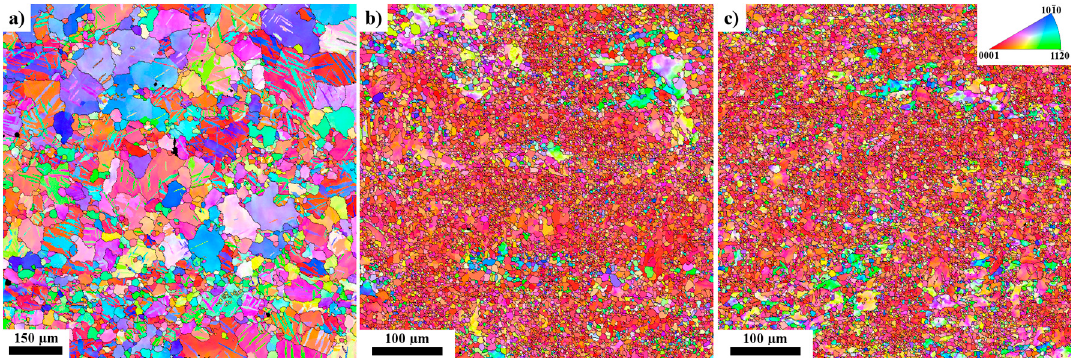
Figure 4. EBSD microstructure of the investigated samples. ( a ) ARB_0; ( b ) ARB_1 and ( c ) ARB_2.